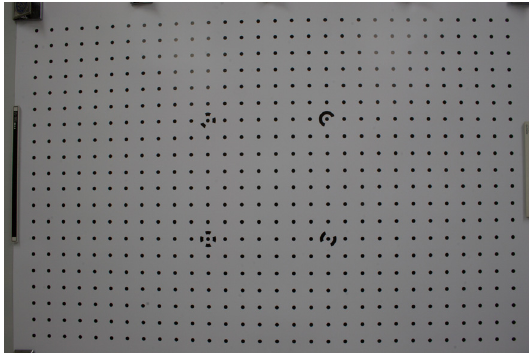
Figure 2. Image utilized in the